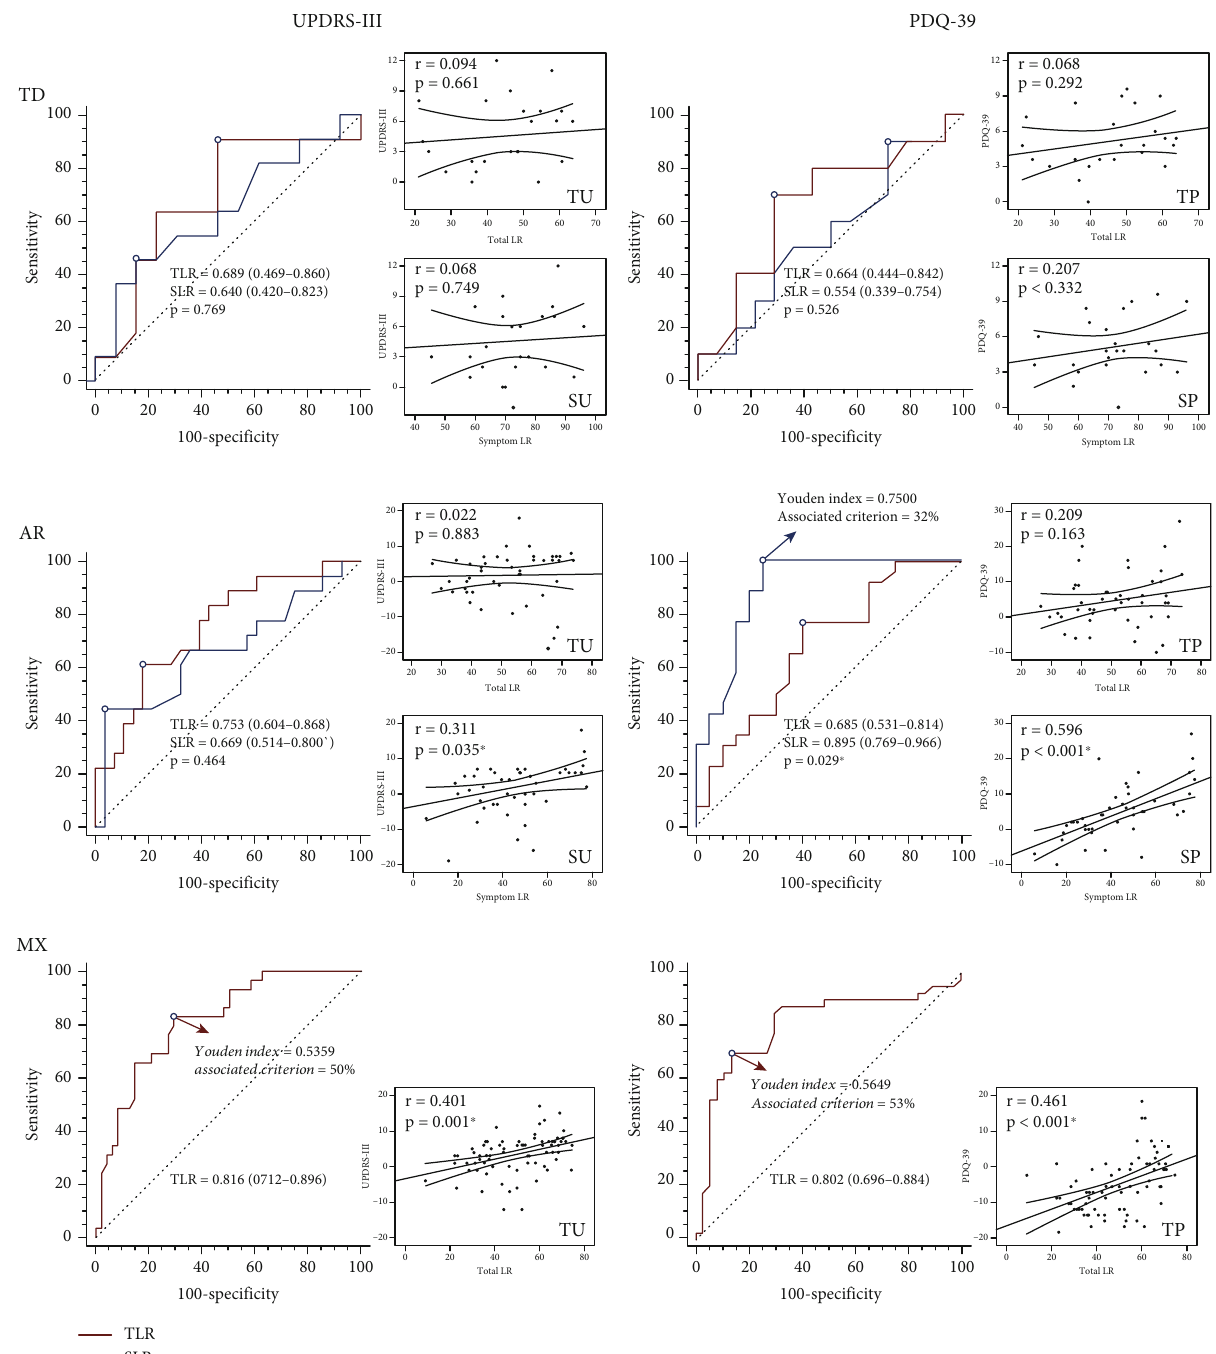
Figure 2: The receiver operating characteristic curves and scatter plots between TLR or SLR and postoperative STN-DBS bene fi ts among the three PD motor subtypes in the training set. Signi fi cant correlations or comparisons are highlighted in bold and marked by ∗